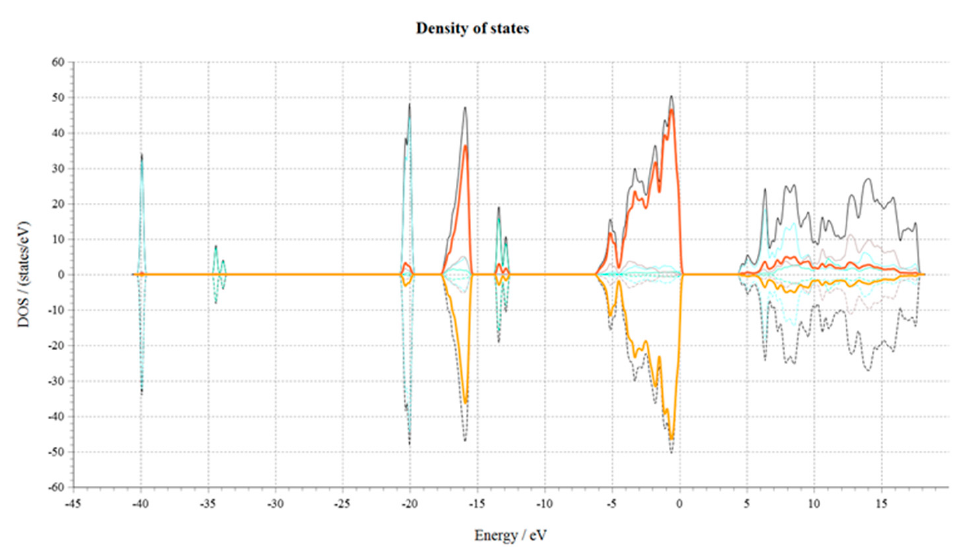
Figure 16. The density of states of YAG:Eu (three ions).